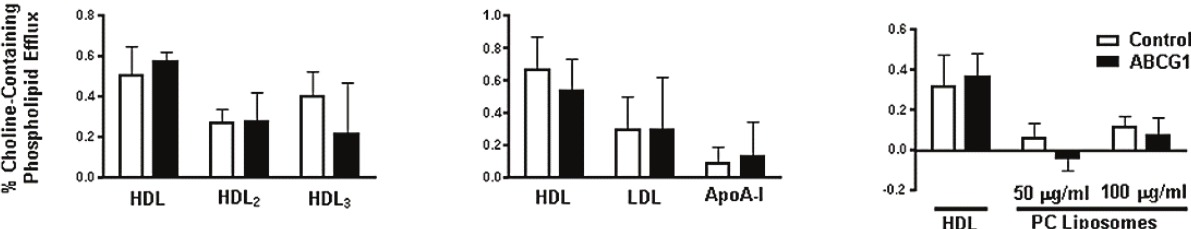
Figure 5. ABCG1-GFP expression does not alter cellular phospholipid efflux. Control and ABCG1-GFP stably expressing HeLa cells were labeled with 3 H-methyl-choline and phospholipid efflux to 50 μg/mL HDL, HDL 2 , HDL 3 , LDL, or 10 μg/mL apoA-I was